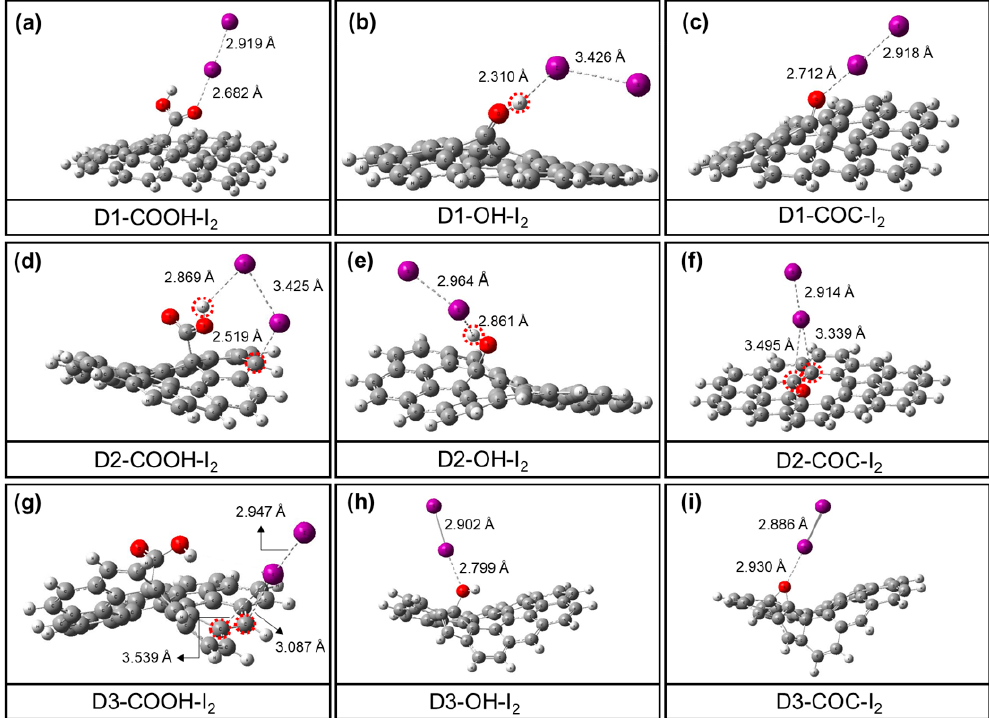
Figure 9. Optimized structures for single-defect structure ( a – c ), double-defects structure ( d – f ) and triple-defects structure ( g – i ) with B3LYP functional.